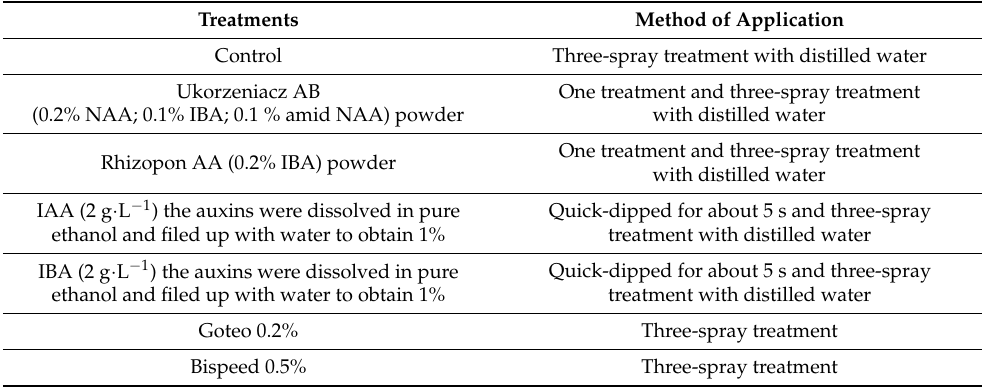
Table 1. Used treatments for root formation ‘GiSelA 5’ softwood